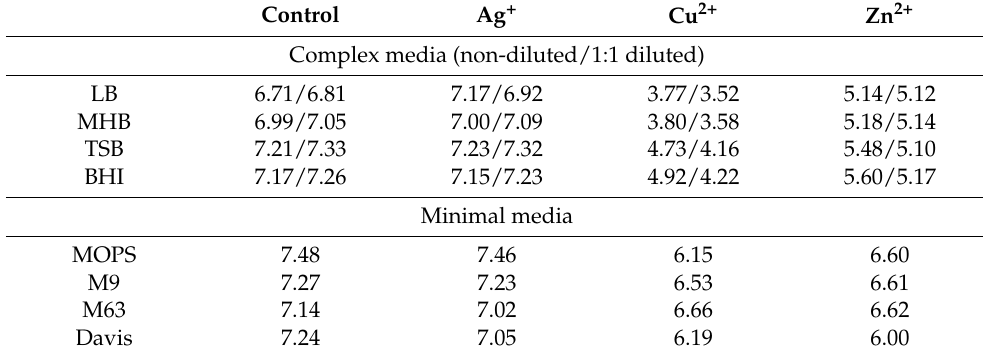
Table 4. pH values of tested media supplemented with 1 mg/mL Ag + /Cu 2+ /Zn 2+